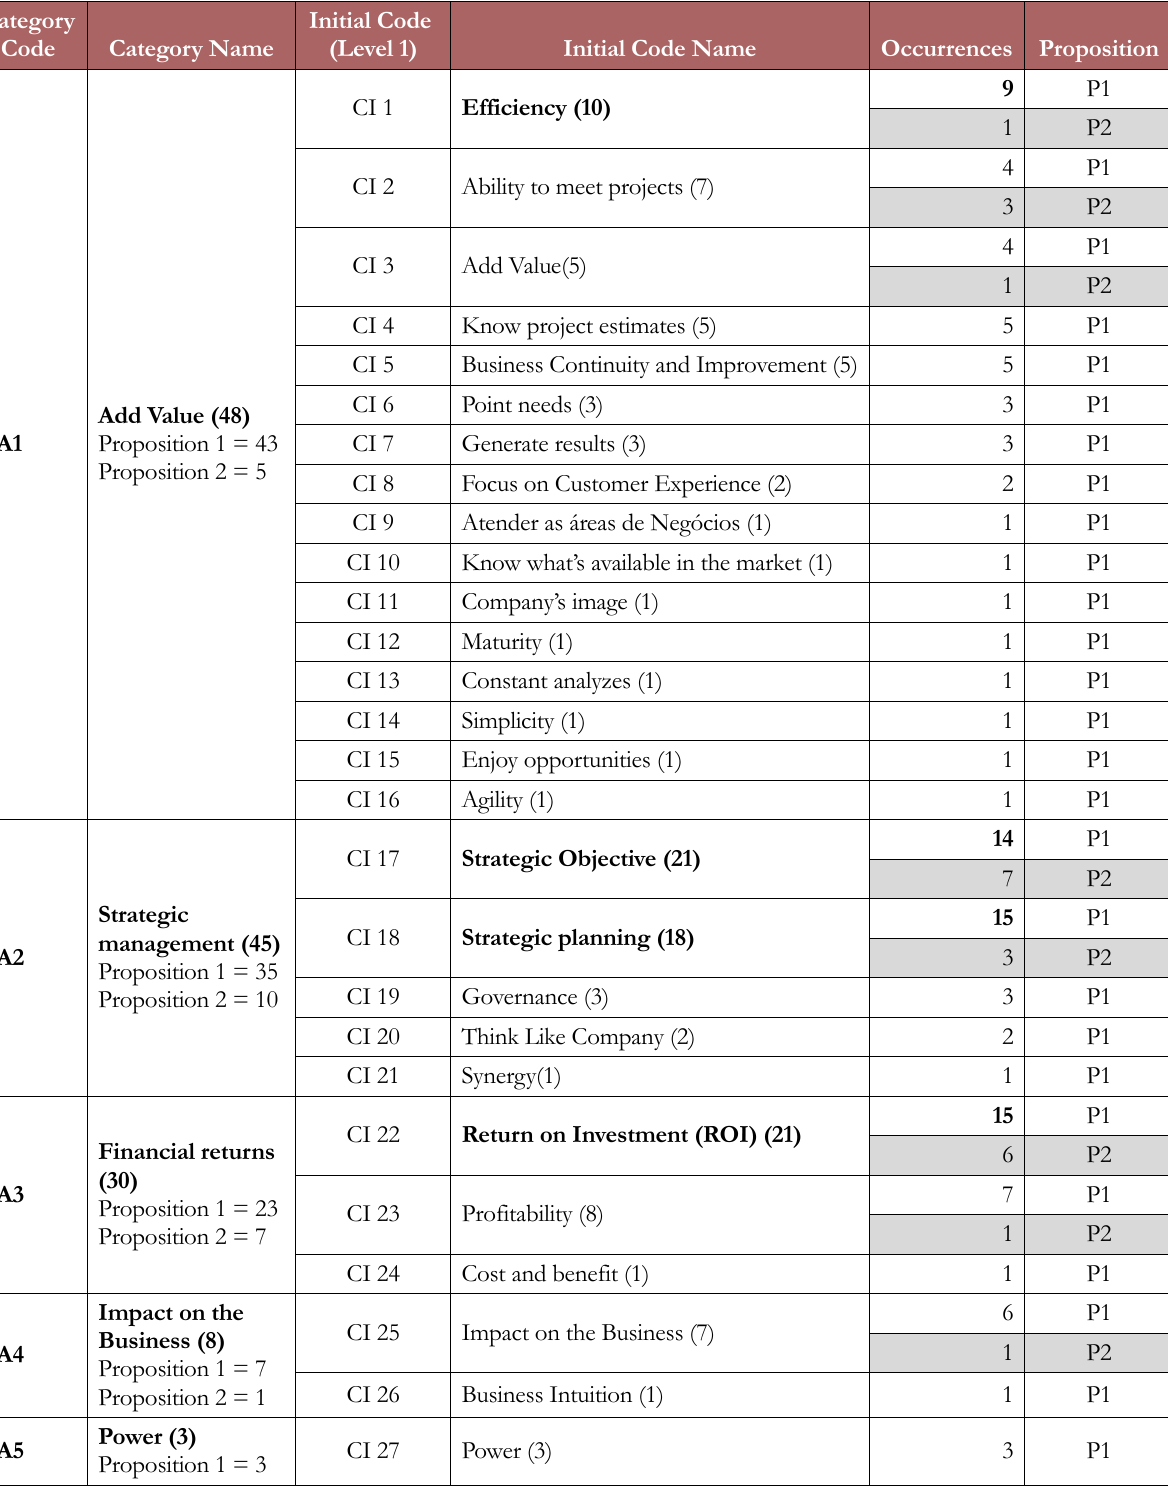
Table 6. Table of data